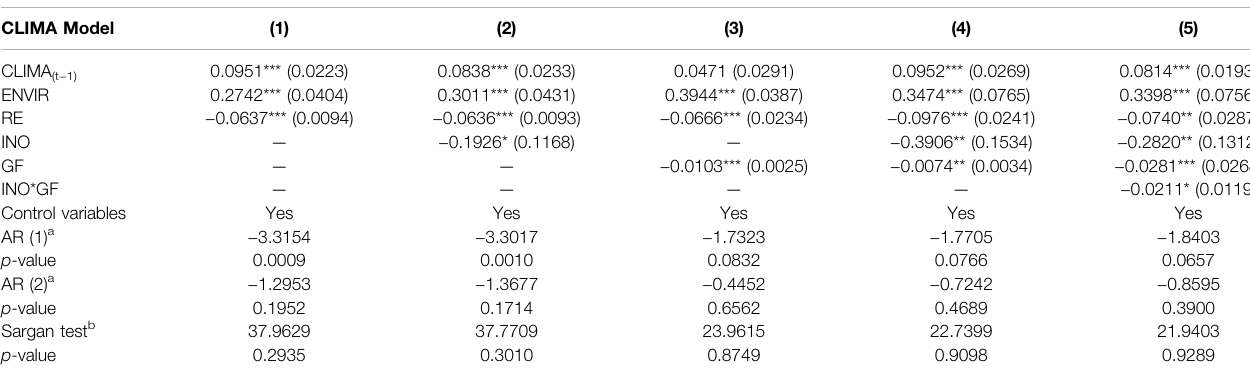
TABLE 6 | Climate change